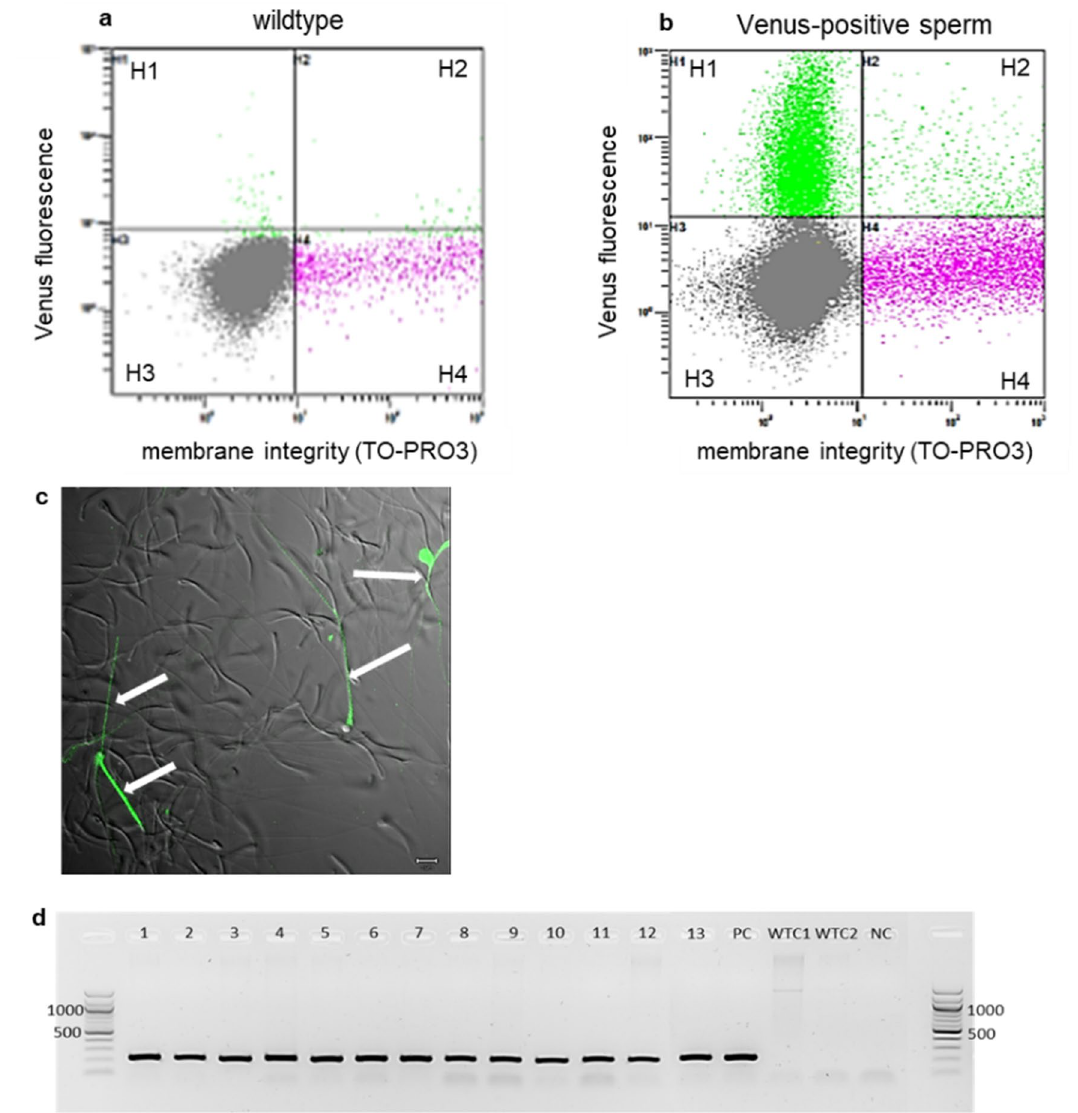
Figure 4. Venus fluorescence of semen from germline-chimeric rooster. ( a + b ) Scatterplot image of flow cytometry data from one germline chimeric rooster in comparison to a wildtype control, H1 = Venus-positive and vital, H2 = Venus-positive and non-vital, H3 = Venus-negative and vital, H4 = Venus-negative and non-vital; ( a ) wildtype rooster non-transfected (Venus-negative control); ( b ) Venus transfected germline chimera with the highest amount of vital and Venus-positive sperm amongst the tested rooster (H1); ( c ) Phase contrast and fluorescence of sperms (Merge), Venus-positive sperms (white arrows) (scale bar: 5 µm); ( d ) Venus-PCR of 13 male germline chimeras (1–13), PC = positive control, NC = water sample, WTC = wildtype control (Venus- negative